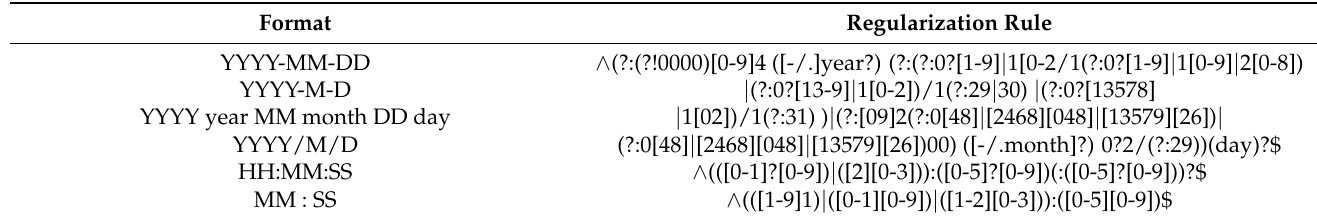
Table 1. Some rule templates for dates and events.